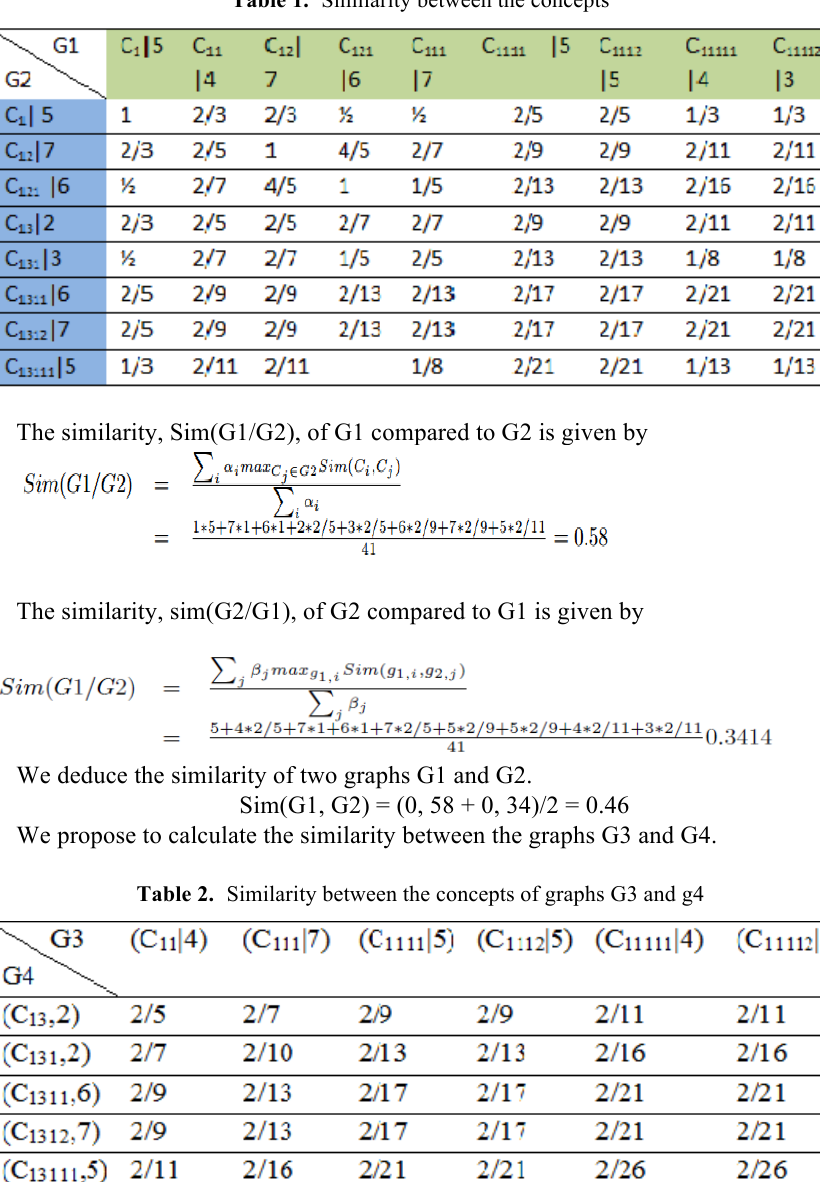
Table 1. Similarity between the concepts